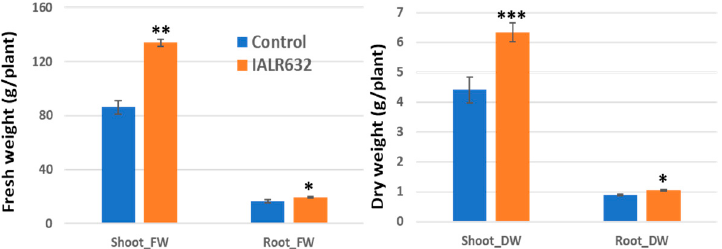
Figure 2. Effects of IALR632 inoculation on Green Oakleaf plant growth in greenhouse NFTs (12 April 2021 to 4 May 2021). *, **, *** on the columns mean statistically significant difference at p < 0.05, 0.01 and 0.001, respectively.